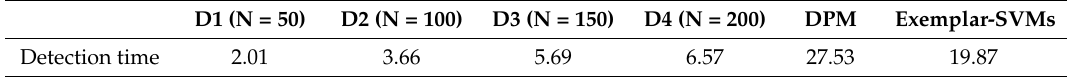
Table 5. Per image detection time of each detector